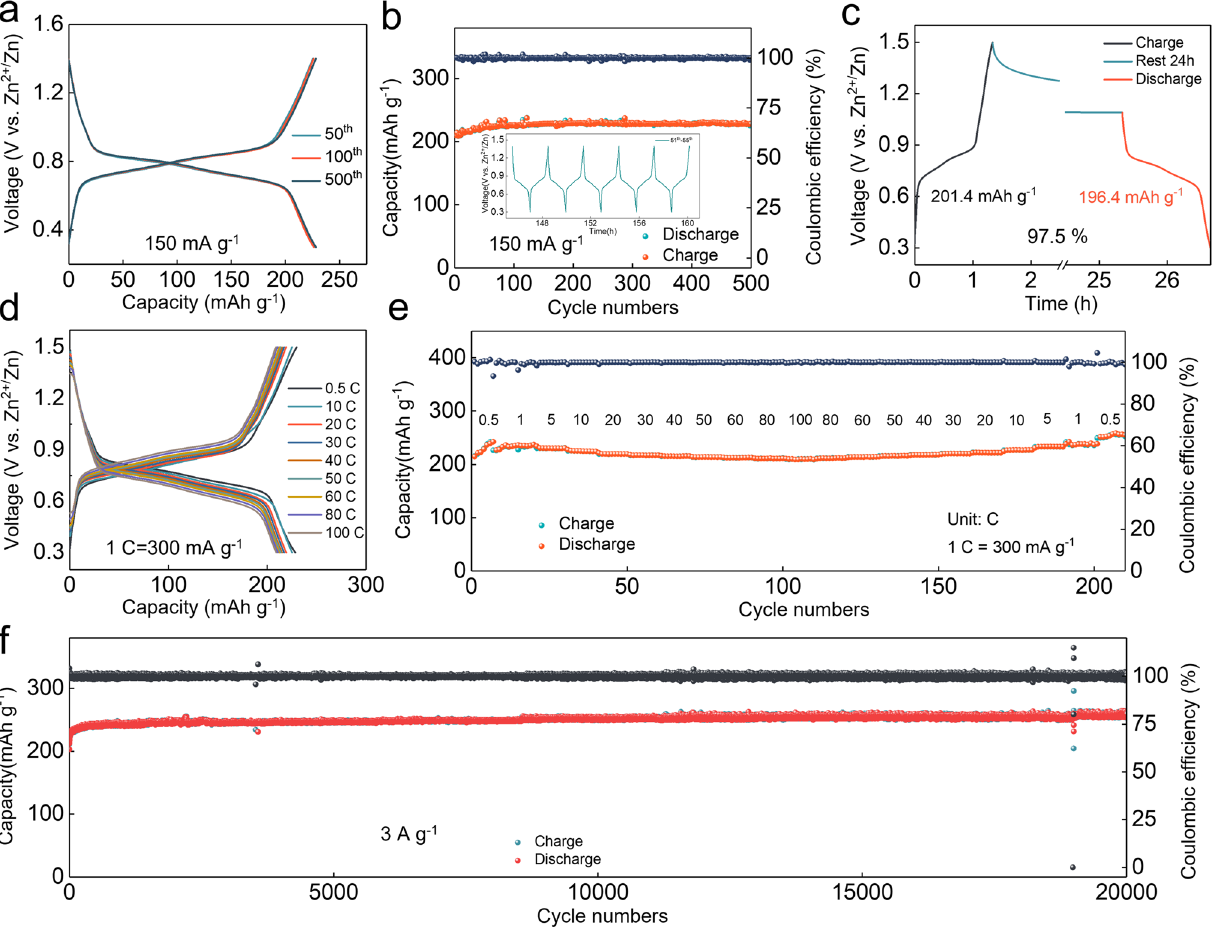
Fig. 3 Electrochemical performance. a GCD curves of Zn//4S6Q battery at 150 mA g −1 . b Cycling stability of Zn//4S6Q battery at 150 mA g −1 . c Self-discharge performance of Zn//4S6Q battery. d GCD curves of Zn//4S6Q battery at different current densities. e Rate performance of Zn//4S6Q battery. f Cycling stability of Zn//4S6Q battery at 3 A g.